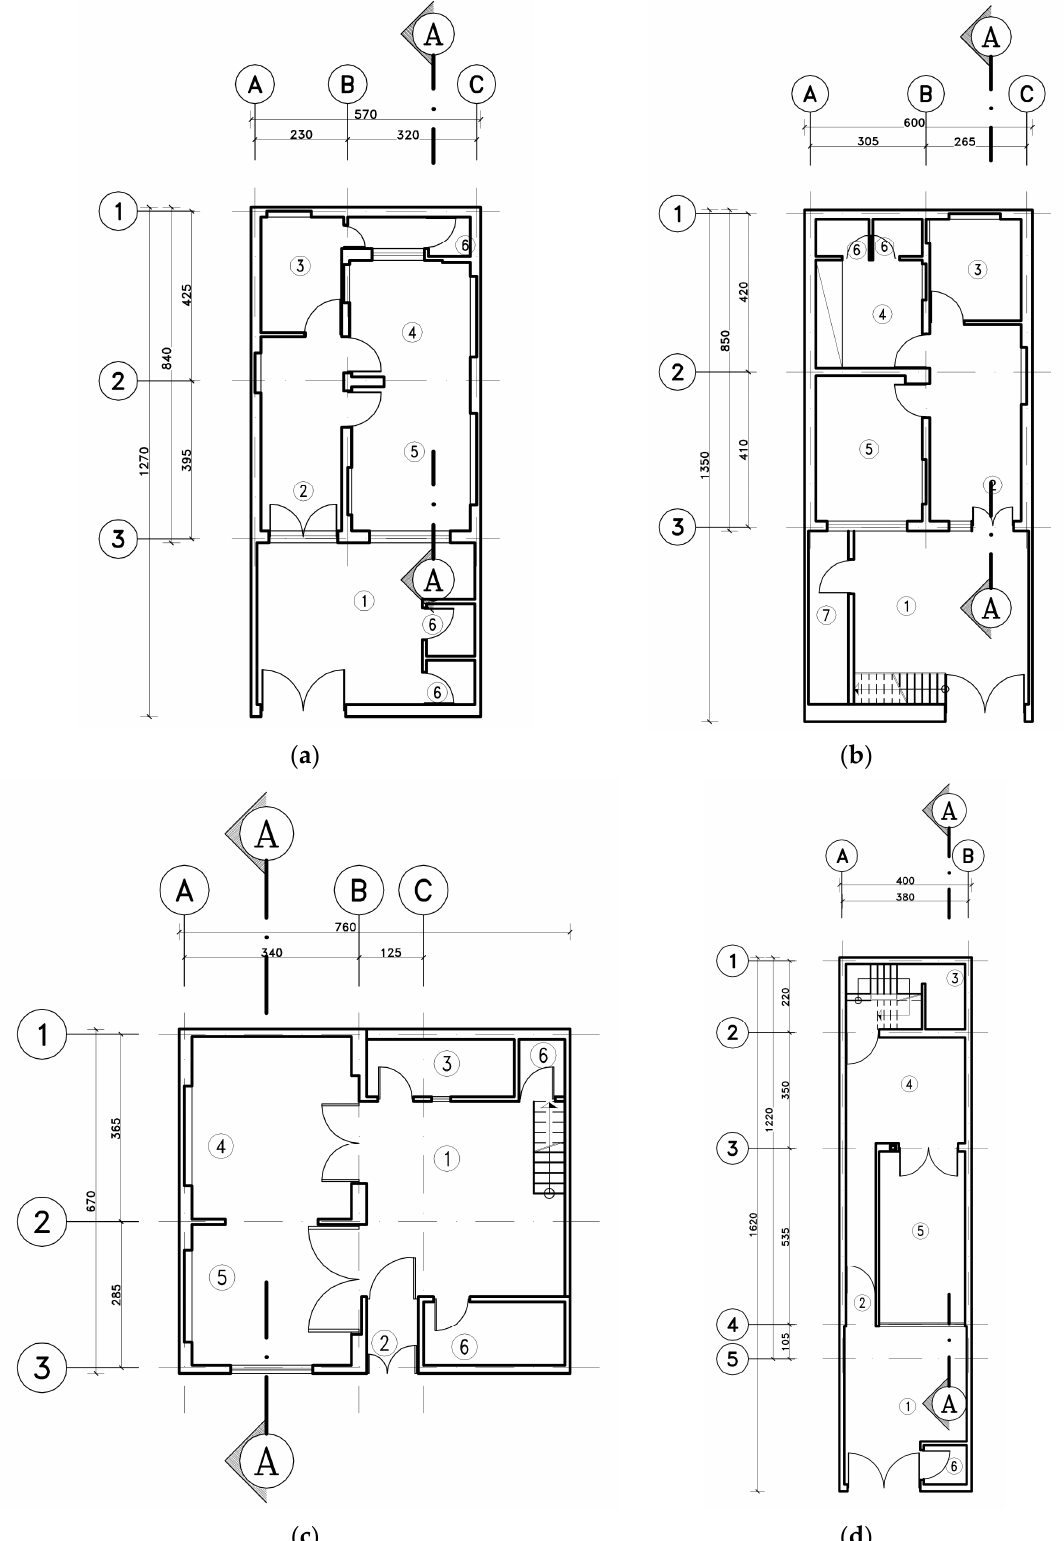
Figure 4. Geometrical characteristics of the representative URM residential buildings in worn-out areas in Tehran (dimensions are in cm); ( a ) Type-1 (single-story); ( b ) Type-2 (two-story); ( c ) Type-3 (two-story); ( d ) Type-4 (three-story).